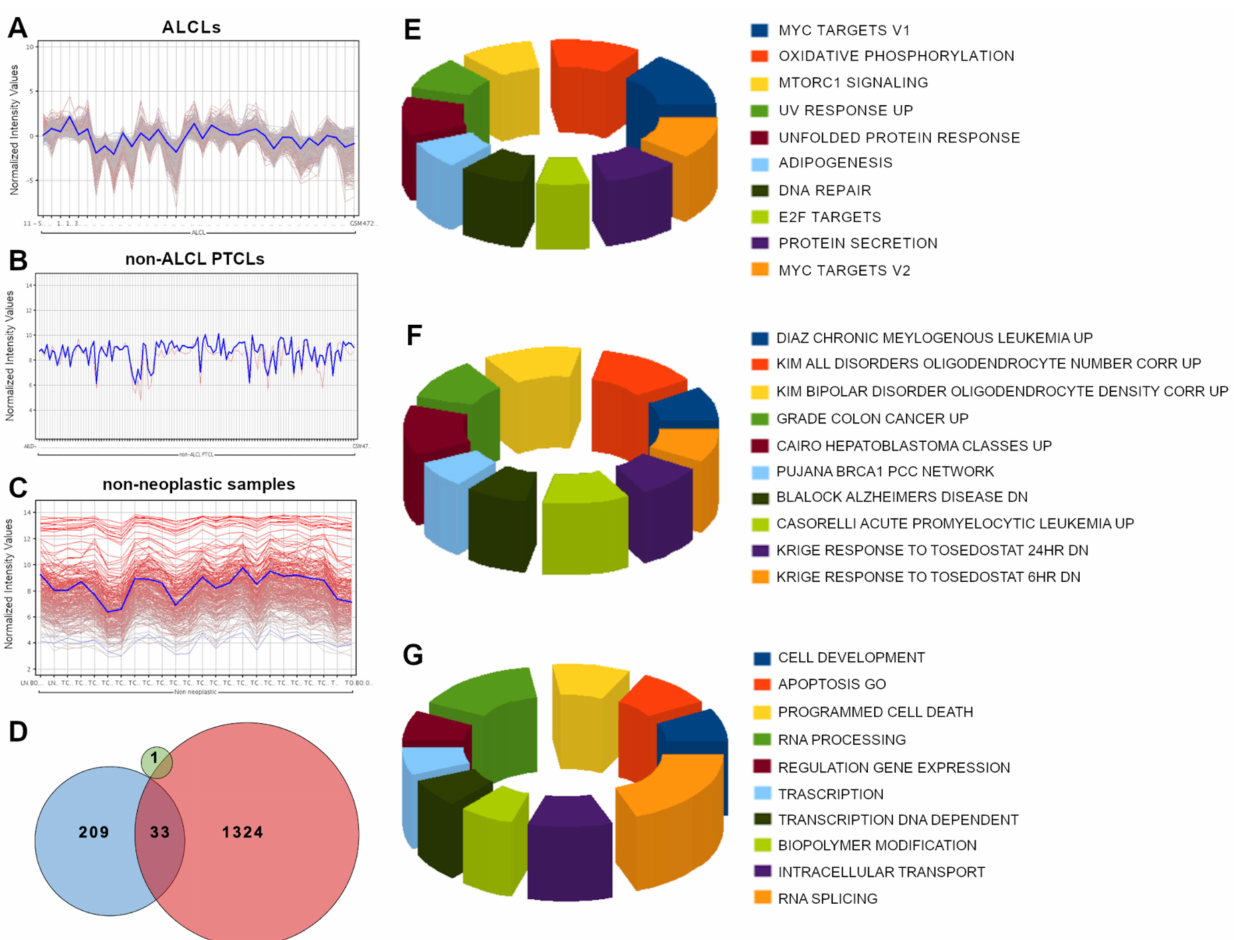
Figure 2. GEP analysis and GSEA results of the genes related to SELPLG . GEP analysis identified the presence of several genes showing a positive Pearson product-moment correlation coefficient (0.75–1) with SELPLG gene expression in ALCLs ( A ), non-ALCL PTCLs ( B ) and non-neoplastic samples ( C ). SELPLG gene presented 1358 significantly correlated genes in the ALCL setting (red), 242 in non-neoplastic samples (cyan) and 1 in non-ALCL PTCLs (green). In total, 1324 were exclusively correlated with the SELPLG gene within the ALCL setting ( D ). GSEA results of the genes related to SELPLG in ALCLs, comprising hallmark gene sets ( E ), C2 curated gene sets, chemical and genetic perturbations ( F ) and GO enrichment analysis ( G